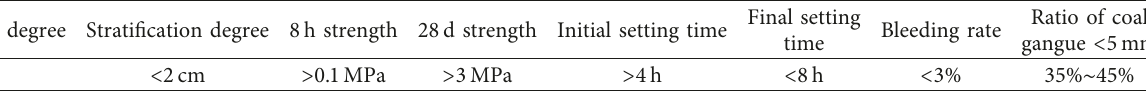
Figure 1: Scanning electron micrograph of grade III fly ash. (a) Magnification 1000 times; (b) magnification 2000 times. Table 1: Proportioning principle of paste filling material.